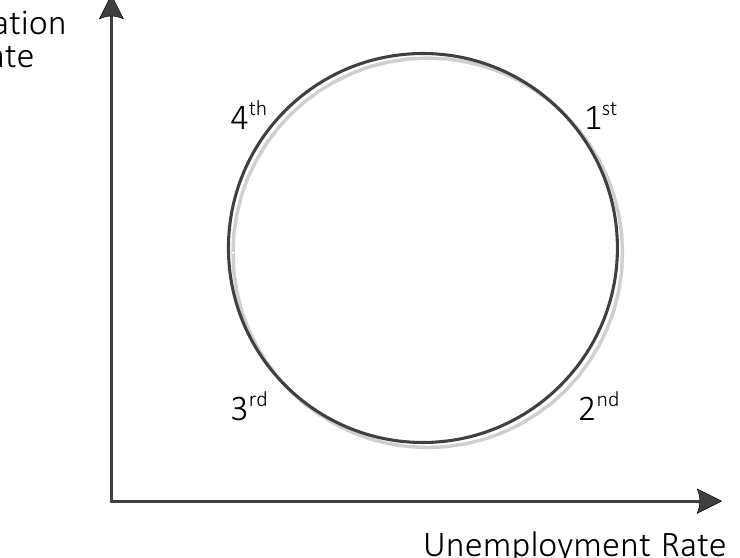
Figure 5. Long-term Phillips curve for the Czech